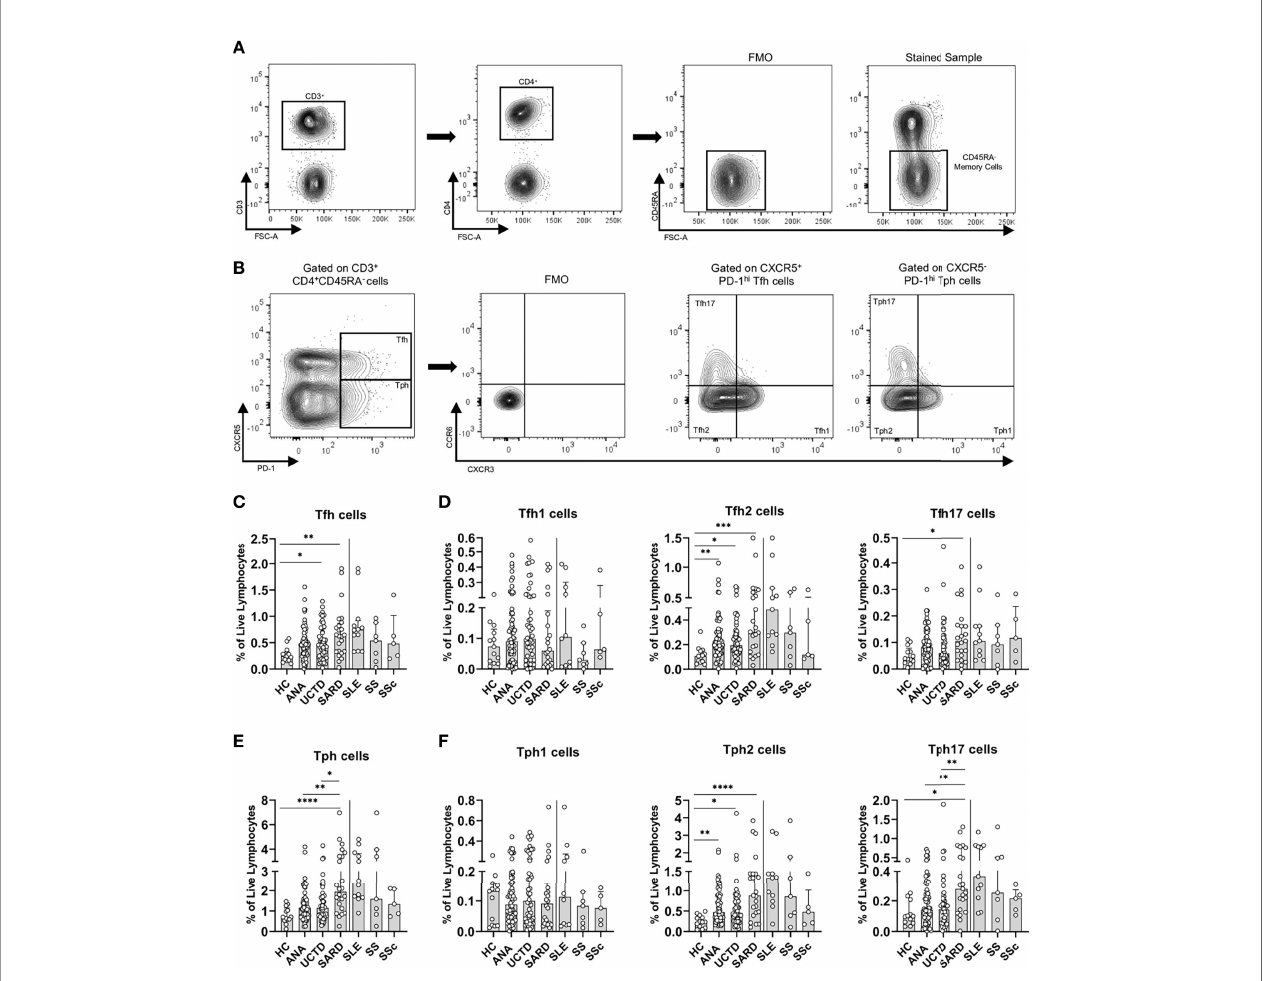
FIGURE 1 | Asymptomatic anti-nuclear antibody positive (ANA + ) individuals lacking a diagnosis of systemic autoimmune rheumatic diseases (SARD) have abnormalities in T helper subsets that are ampli fi ed in symptomatic patients with early SARD. (A) Gating strategy for identi fi cation of (CD3 + CD4 + CD45RA - ) memory T cells from the peripheral blood mononuclear cells of a representative ANA + patient. (B) Gating strategy for identi fi cation of T follicular helper (Tfh, PD-1 hi CXCR5 + ) and T peripheral helper (Tph, PD-1 hi , CXCR5 - ) cells and the Th1 (CXCR3 + , CCR6 - ), Th2 (CXCR3 - , CCR6 - ), and Th17 CXCR3 - , CCR6 + ) subsets within these populations. (C, D) The proportions of Tfh cells and the individual Tfh subsets within the memory T compartment strati fi ed by subject group. (E, F) The proportions of Tph cells and the individual Tph subsets within the memory T compartment strati fi ed by subject group. The solid vertical line in each plot separates the groups that were statistically compared to one another from the individual SARD on the right, which were not statistically compared to any group. Bars represent the median with interquartile range. Each data point represents an individual subject. Statistical signi fi cance was determined using the Kruskal-Wallis test with Dunn ’ s post-hoc test for multiple comparisons; *p ≤ 0.05, **p ≤ 0.01, ***p ≤ 0.001, ****p ≤ 0.0001. HC, ANA - healthy control; ANA, asymptomatic ANA + ; UCTD, undifferentiated connective tissue disease; SARD, systemic autoimmune rheumatic disease; SLE, systemic lupus erythematosus; SS, Sjögren ’ s syndrome; SSc, systemic